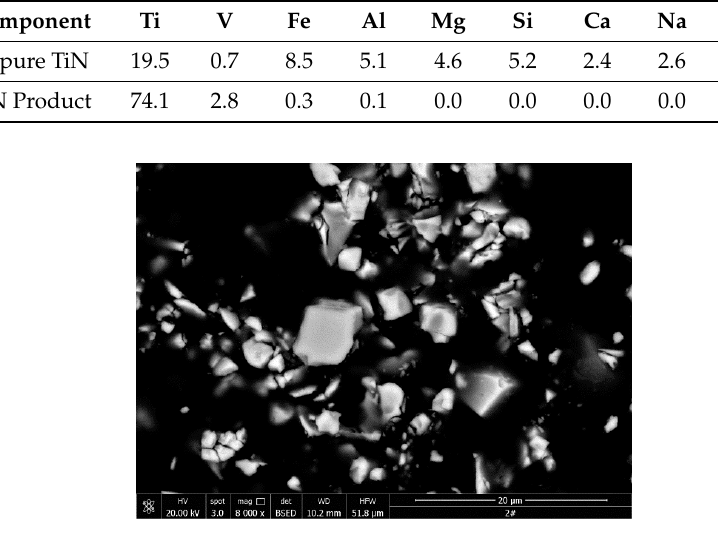
Figure 10. SEM image of the purified TiN product .